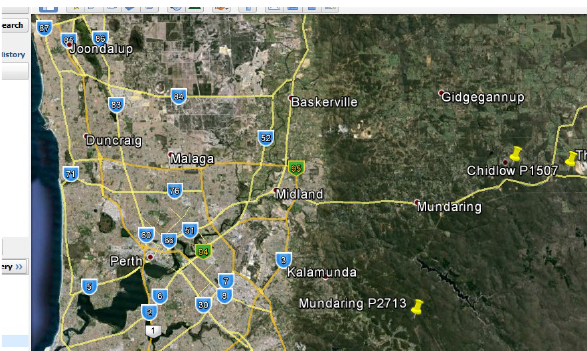
Figure 2. Locations of three registered apiary and spectral measurement sites, indicated by “pin” locations (Google, 2016)